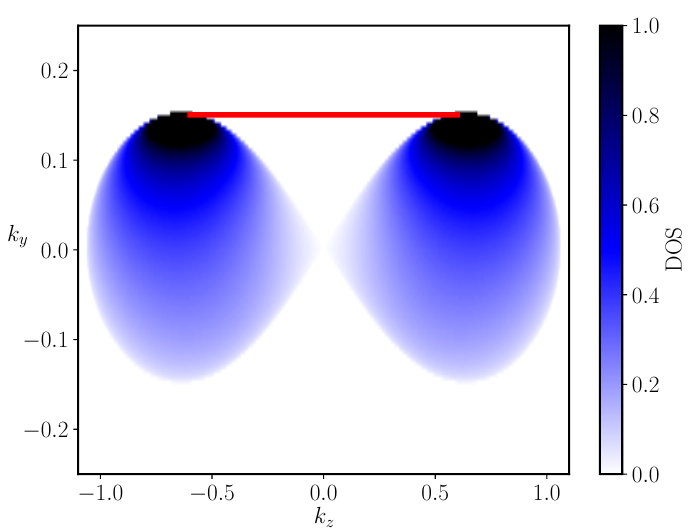
Figure 12: Same as the upper panel of Fig. 11 with an alternative view: the energy E = 0.3 is fixed and the DOS is plotted as a function of ( k